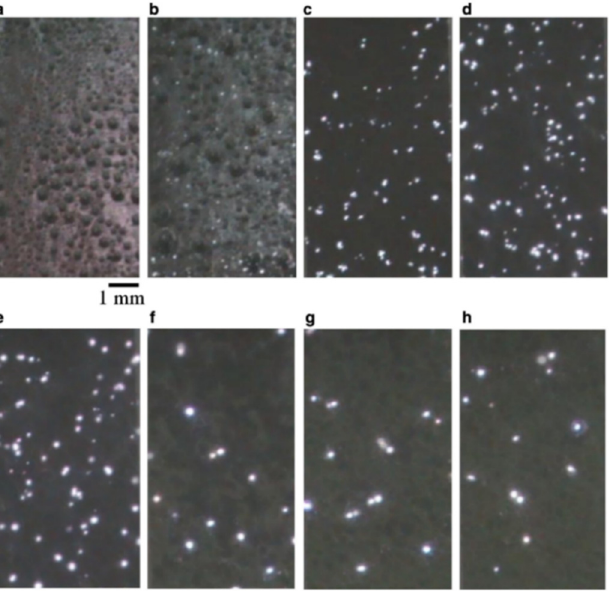
Figure 6. Real-time images of the MAO process of Ta using tungstosilicic acid electrolyte at ( a ) 10 s, ( b ) 20 s, ( c ) 1, ( d ) 3, ( e ) 5, ( f ) 15, ( g ) 30, and ( h ) 45 min. Reprinted with permission from Ref. [58].